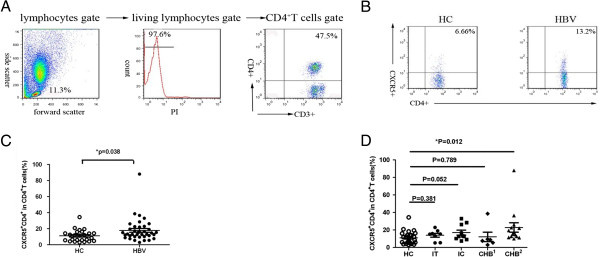
Fluorescence-activated cell sorter (FACS) analysis of the frequency of peripheral blood CXCR5+CD4+ T cells in patients with chronic HBV infection patients. (A) Gating strategy. (B) The percentage of circulating CXCR5+CD4+ T cells was compared between the two groups. (C) The percentage of CXCR5+CD4+ T cells was significantly higher in patients with chronic HBV infection than in healthy controls (P < 0.05). (D) Comparison of the frequency of CXCR5+CD4+ T cells in the IT, IC, CHB(HBeAg+), CHB(HBeAg-) and HC groups. HC, healthy controls; HBV, patients with chronic HBV infection; IT, immune tolerant carrier; IC, inactive carrier; CHB1, HBeAg-negative chronic hepatitis B; CHB2, HBeAg-positive chronic hepatitis B; PI, propidium iodide. The horizontal lines represent the median values (±SEM).